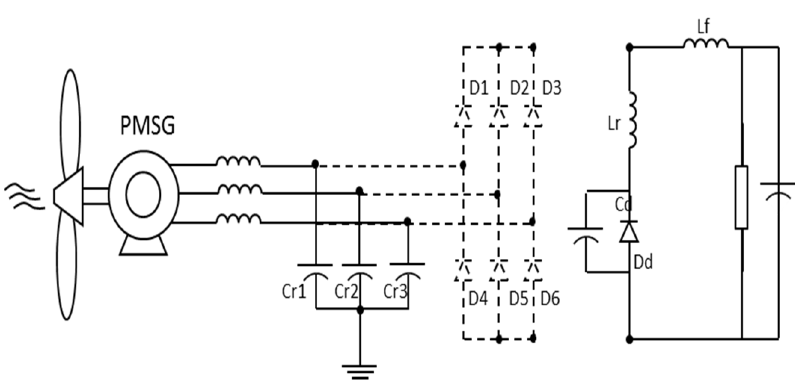
Figure 9. First Stage: Equivalent